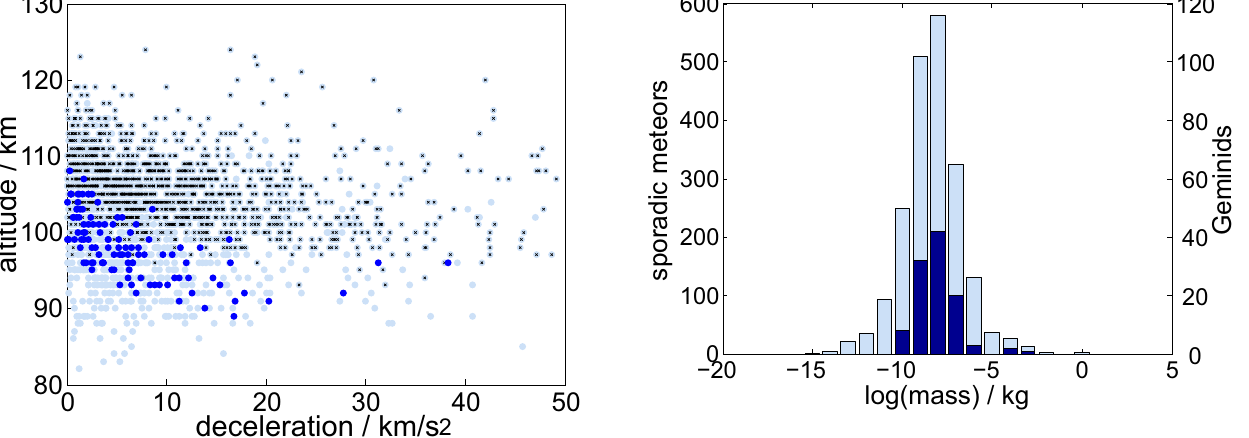
Fig. 15. Histogram of the calculated dynamic meteor masses; dark blue: Geminids; light blue: sporadic meteors.